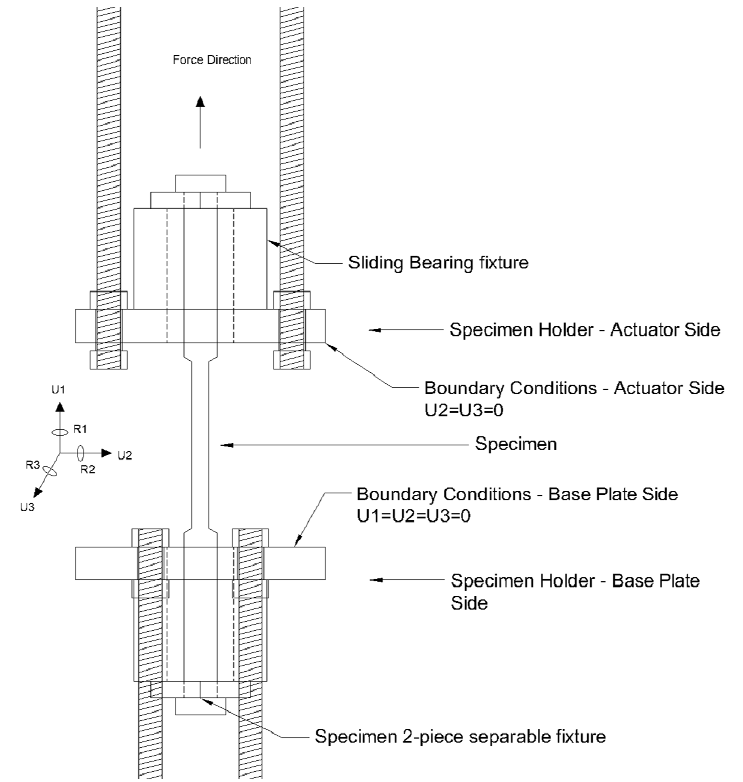
Figure 4. Servo-hydraulic MTS 244.11 technical specifications.